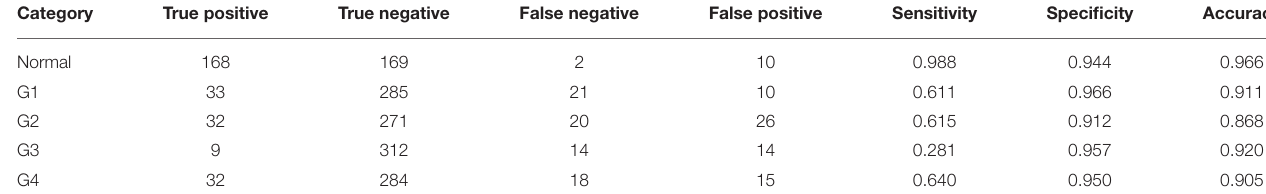
TABLE 3 | The sensitivity, the specificity, and the accuracy of deep learning in the grade classification according to the Amsler-Krumeich classification. False